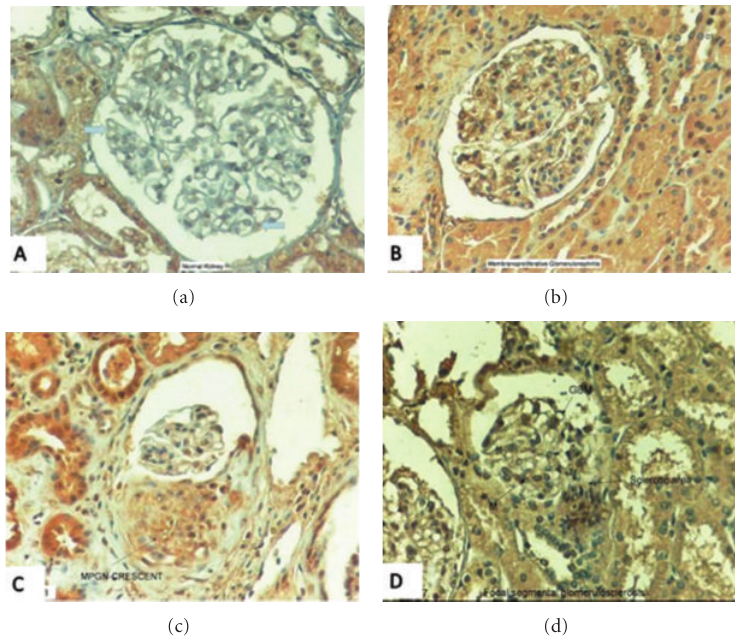
Figure 1: (a) Localization of urotensin-II (U-II) immunoreactivity (brown color) in the normal human kidney. Weak immunostaining in glomerulus, abundant expression of U-II in tubules. Thick arrows: weak immunostaining and black arrow: strong immunostaining [21]. (b) Urotensin-II immunoreactivity in membranoproliferative glomerulonephritis. Immunostaining in glomerular basement membrane, mesangium, Bowman capsule, and tubules. GBM: glomerular basement membrane, MPGN: membranoproliferative glomerulonephritis, BC: Bowman capsule, M: mesangium, PT: proximal tubule, and DT: distal tubule [21]. (c) Localization of urotensin-II immunoreactivity in a crescent [21]. (d) Urotensin-II immunoreactivity in focal segmental glomerulosclerosis. Notice the abundant expression of U-II in sclerotic area